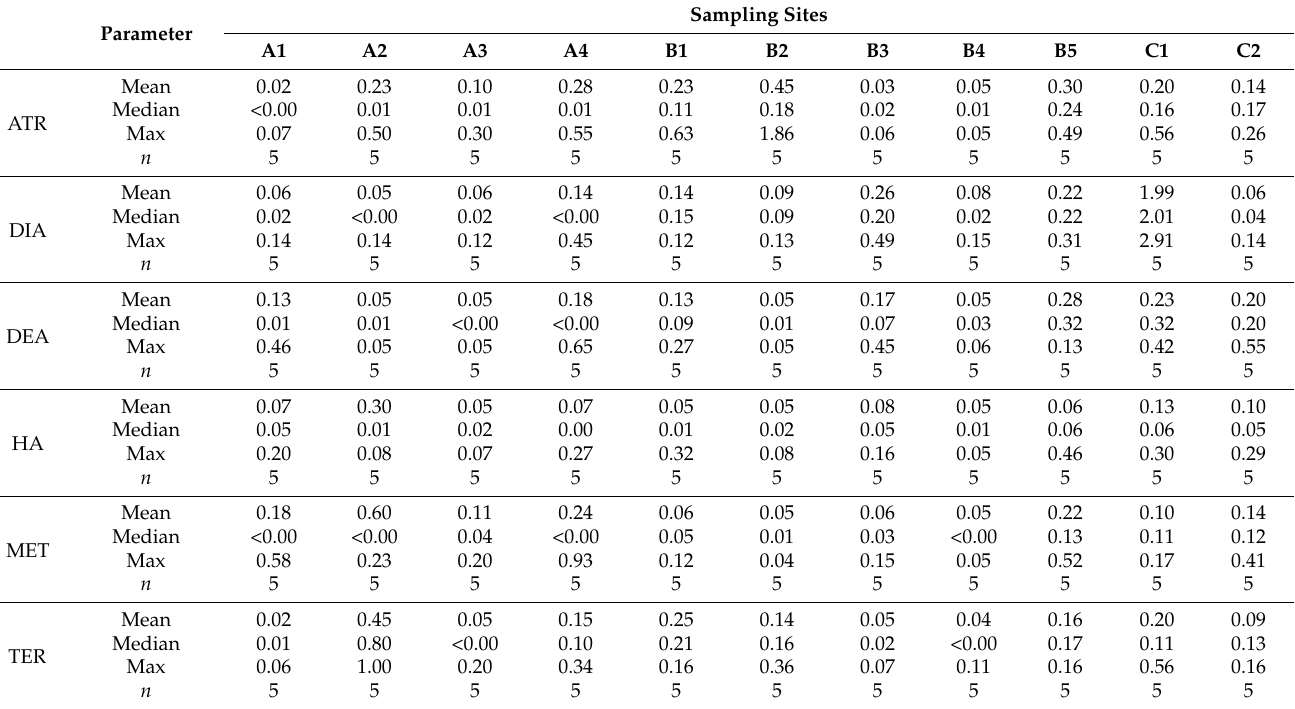
Table 2. Statistics of pesticides concentrations ( µ